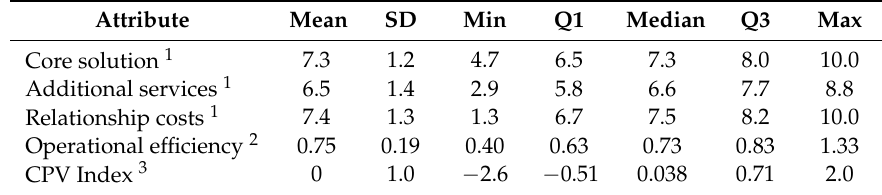
Table 3. Statistics for customer-perceived value for the period 2007–2009. n = 74 for all attributes.